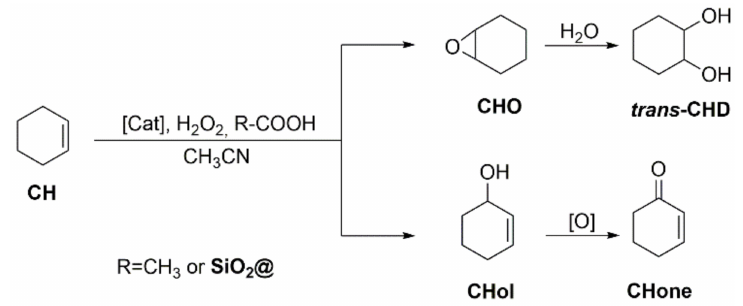
Figure 15. Catalytic oxidation of